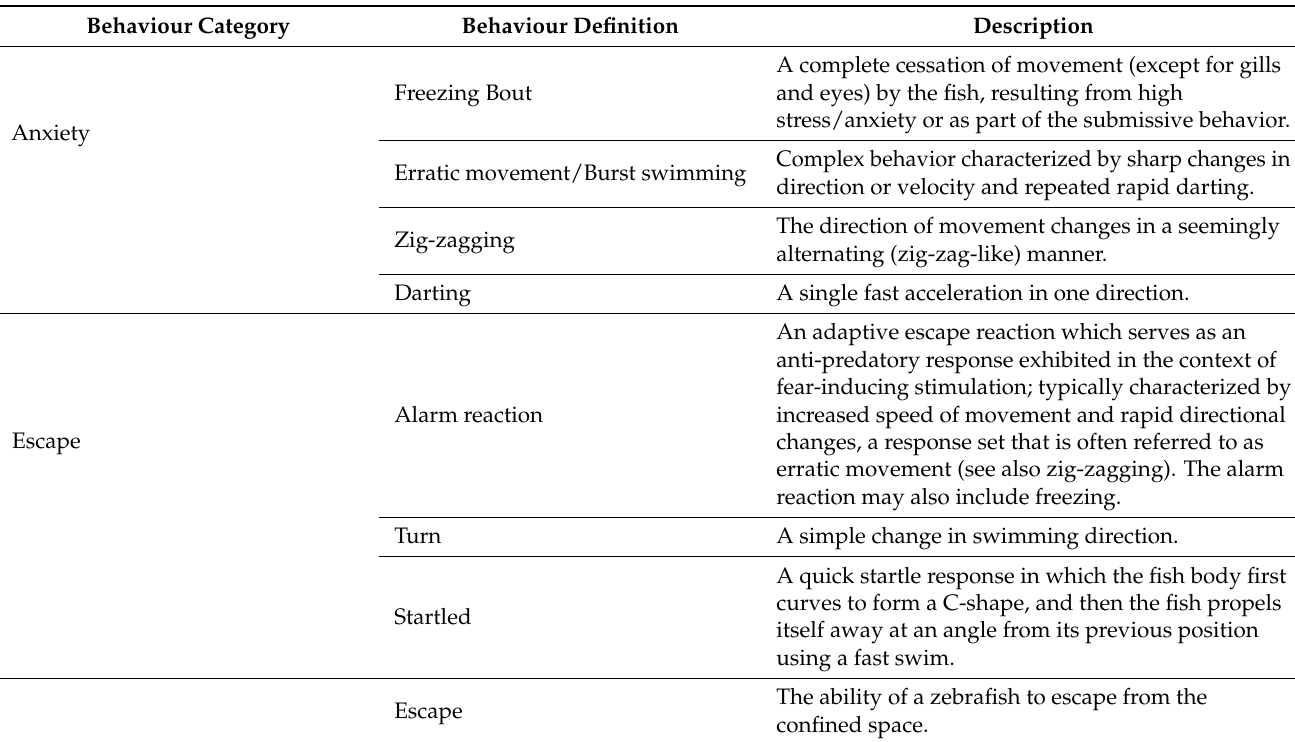
Table 1. Ethogram describing the behaviour category and its definition, as observed in the present study. Behaviour